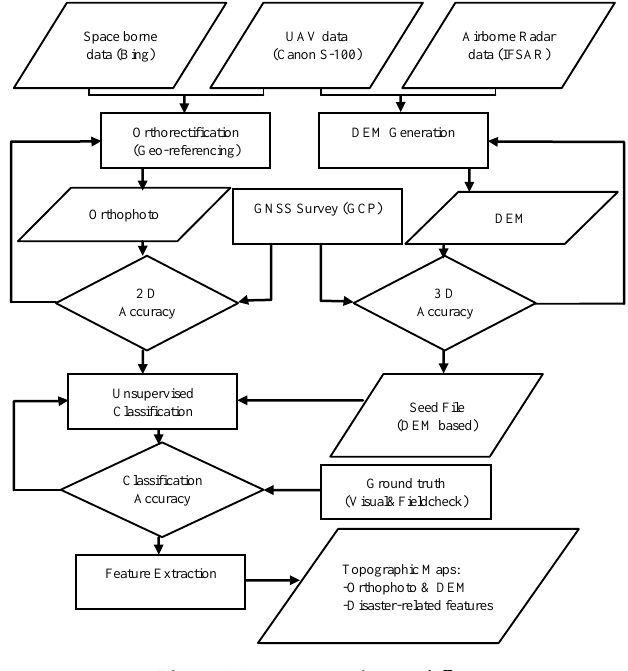
Figure 1. Data processing